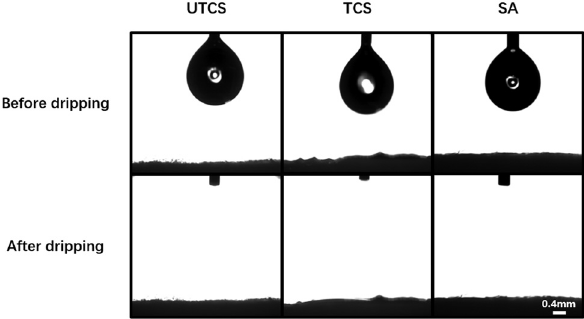
Figure 4: The contact angle of three dressings under wetting con - ditions before and after water drop. Scale bars represent 0.4